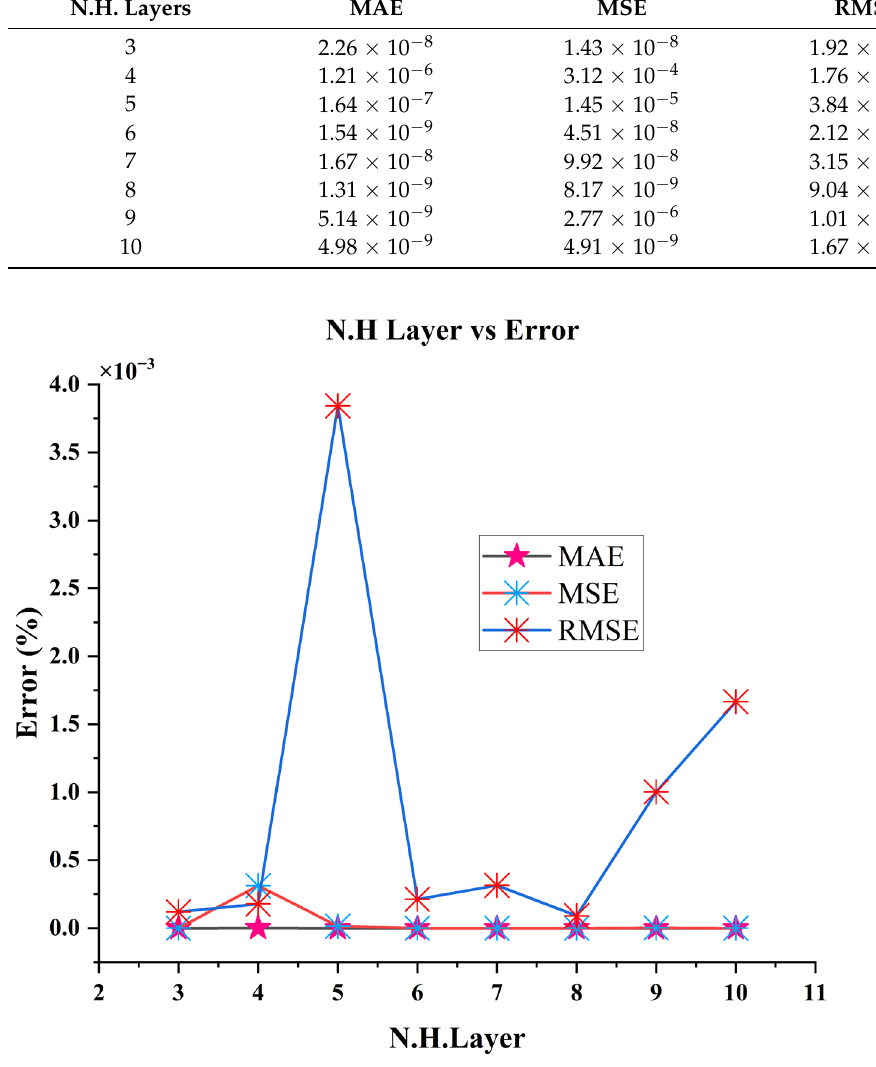
Figure 9. Selection of the permanent hidden layer with the FNN network based on the least-error values MAE (%), MSE (%) and RMSE (%) at hidden layers ranged from (3–10). Table 4 . The MAE, MSE, and RMSE values with the hidden layers ranged between (3 – 10). N. H.Layers